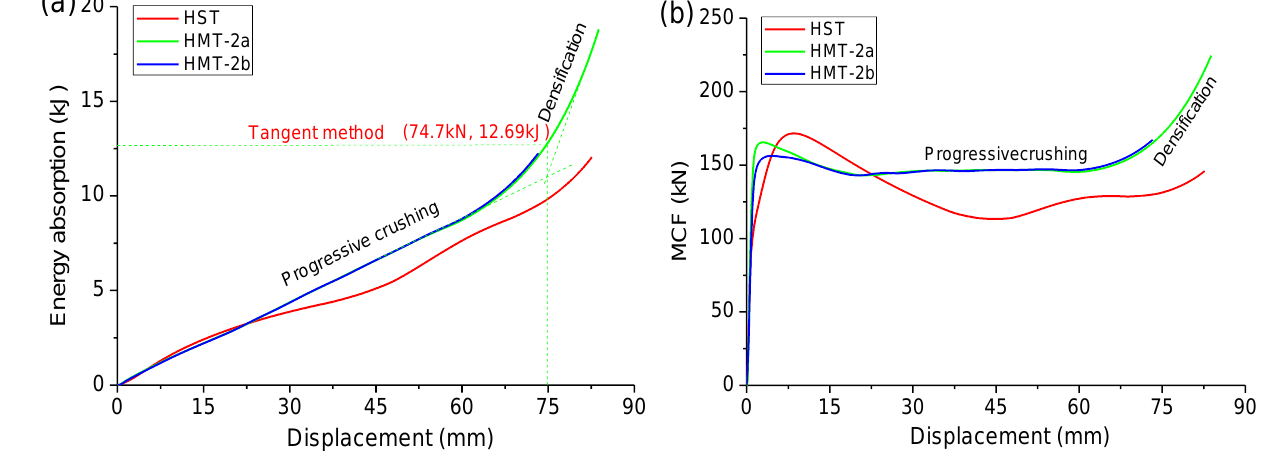
Figure 6. ( a ) Energy absorption and ( b ) MCF of compressed hexagonal HST and HMTs. The HMTs also have much greater MCF than the HST, as shown in Figure 6b. The MCF curves clearly embody the three stages of deformation. In progressive crushing, the MCF changes little. In densification, the MCF increases rapidly. To determine the MCF and the effective crushing distance, local MCF curves were adopted, as shown in Figure 7.